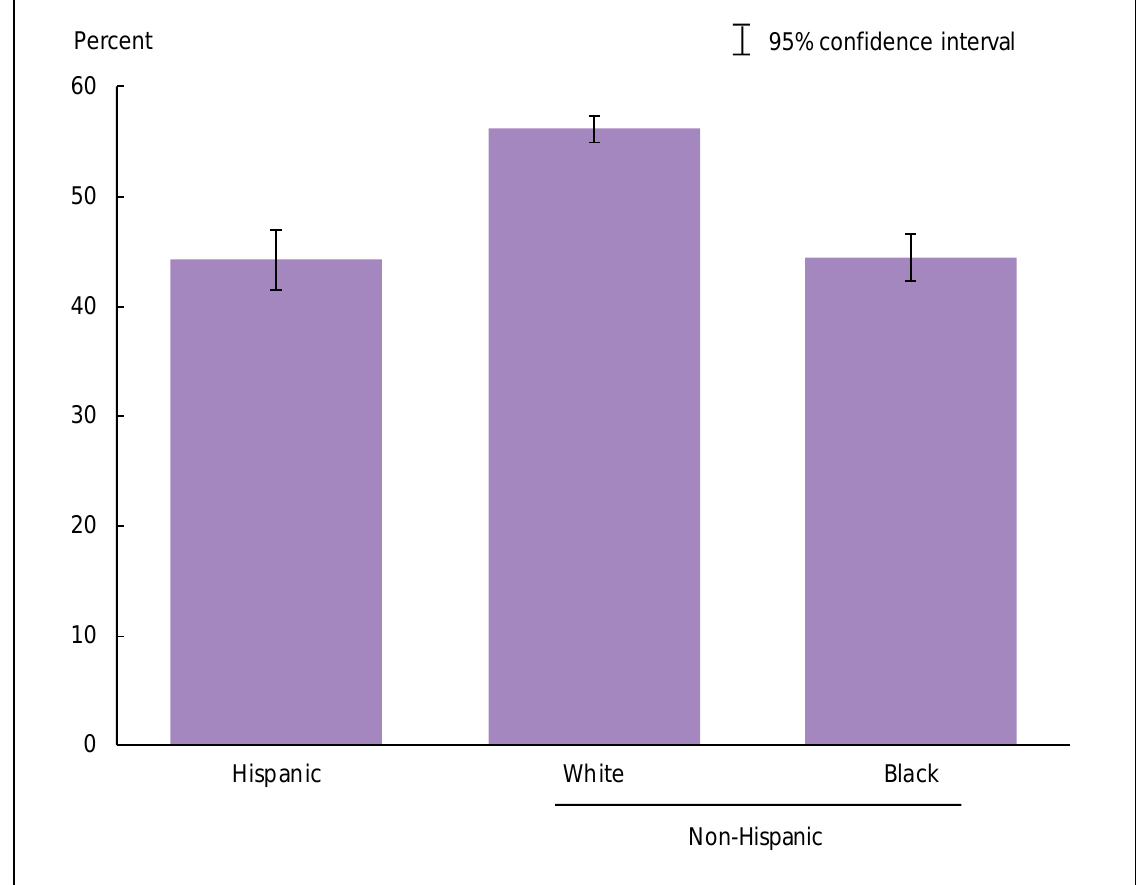
Figure 7.3. Age-sex-adjusted percentage of adults aged 18 and over who met 2008 federal physical activity guidelines for aerobic activity through leisure-time aerobic activity, by race and ethnicity: United States,